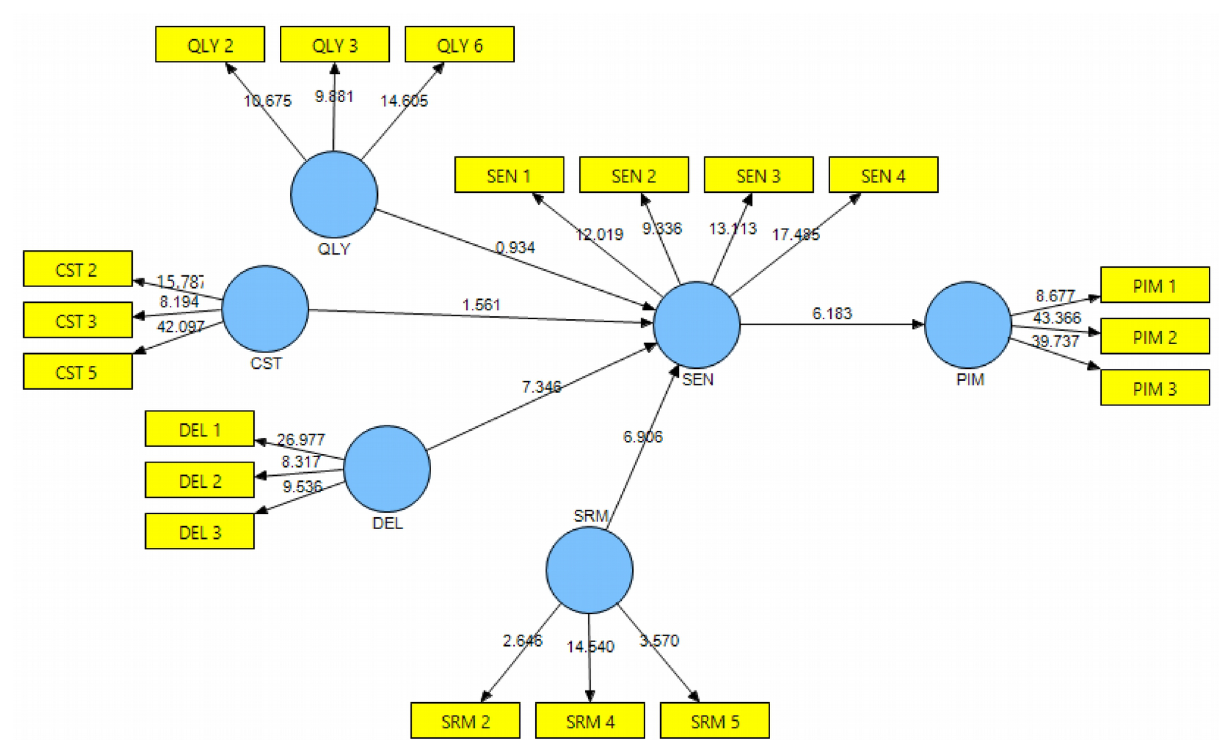
Figure 9. Operational measurement